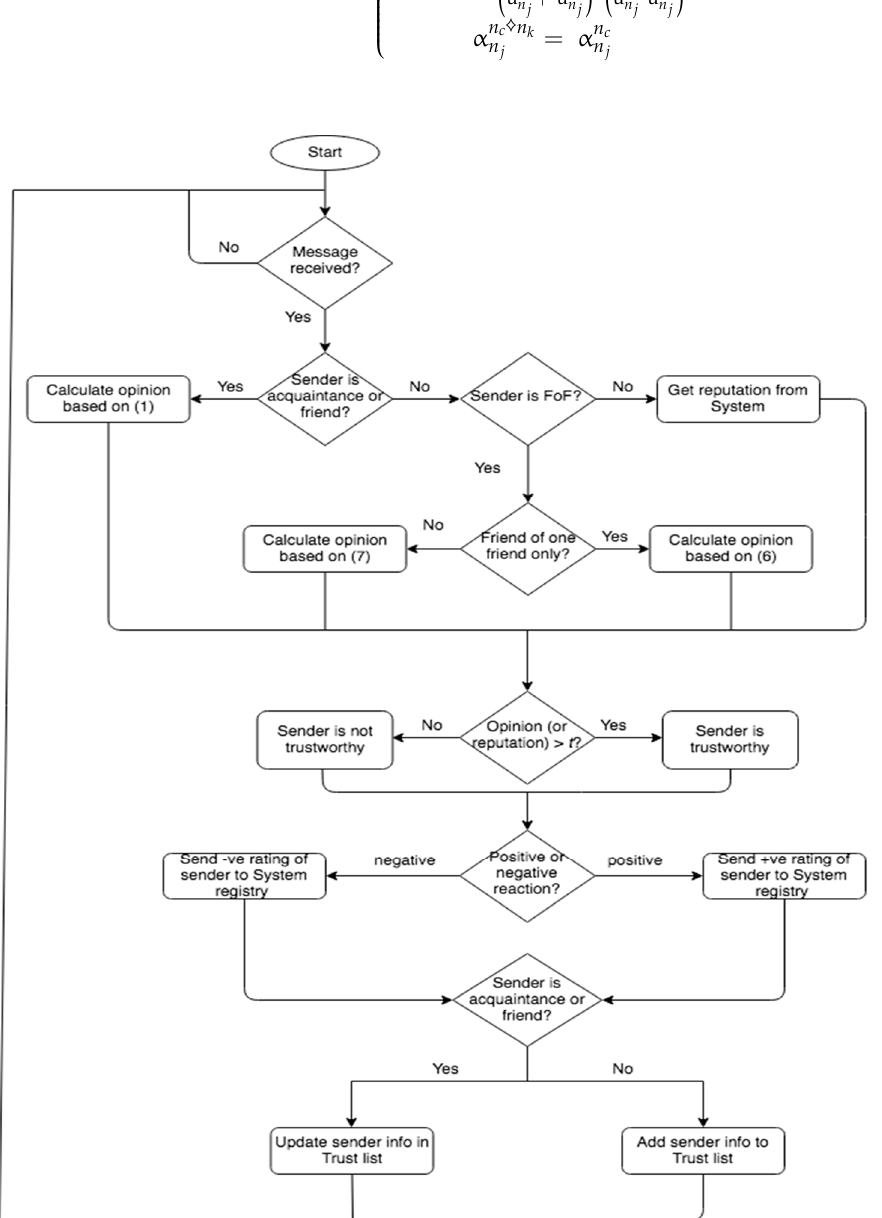
Figure 4. WhatsTrust node algorithm.